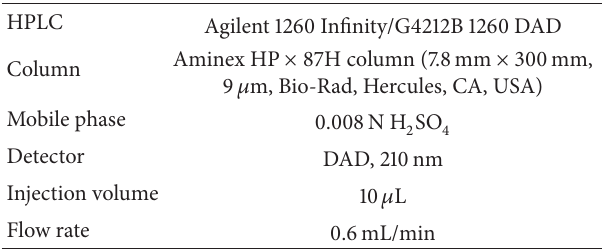
Table 1: HPLC analysis operating conditions and parameters for determination of organic